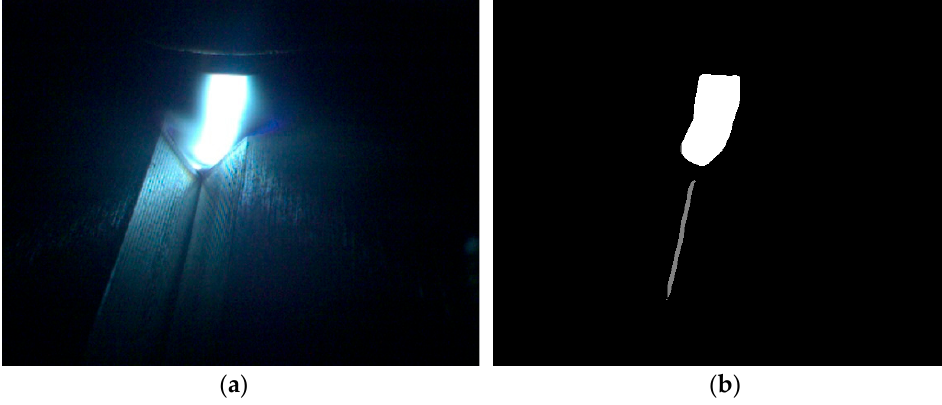
Figure 5. Segmentation of images: ( a ) original images; ( b ) segmented images.